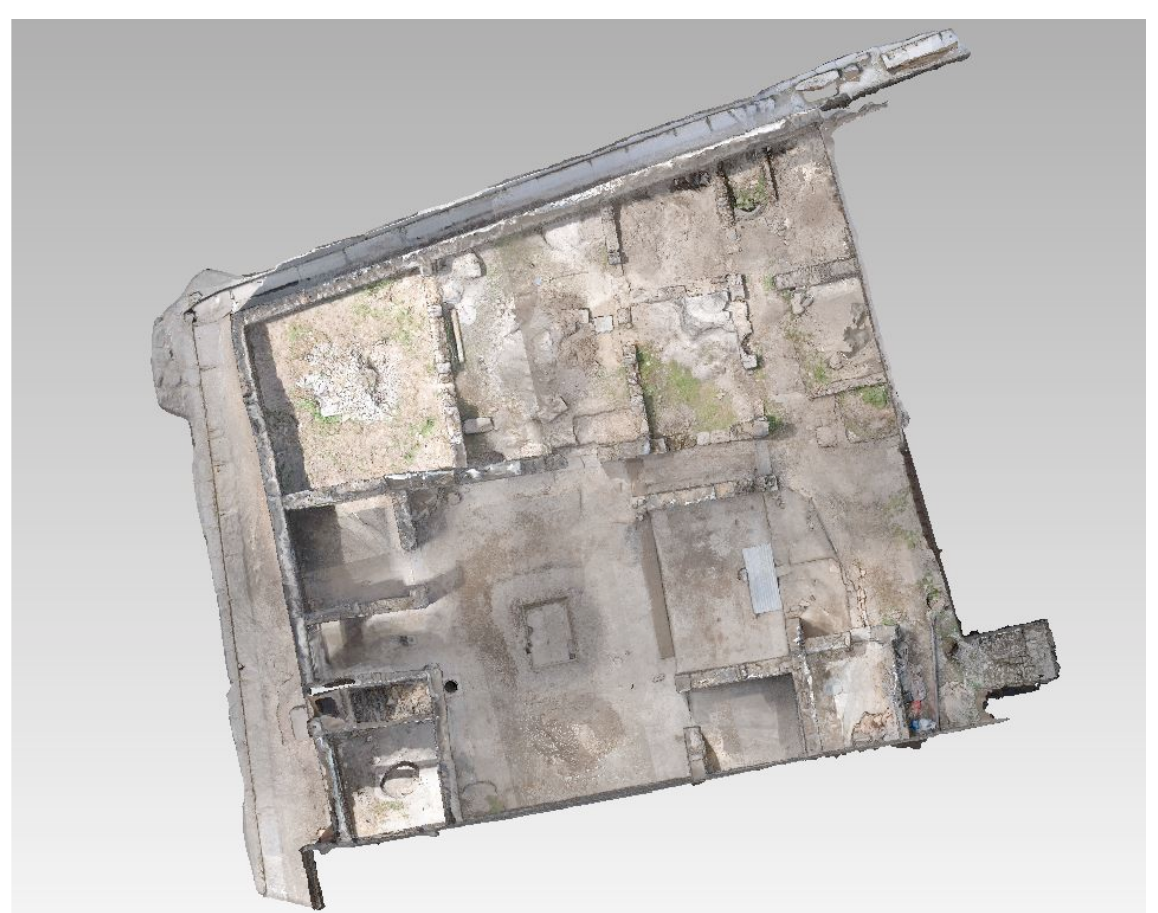
Figure 6. 3D model of Domus of Stallius Eros obtained by terrestrial photogrammetry (top